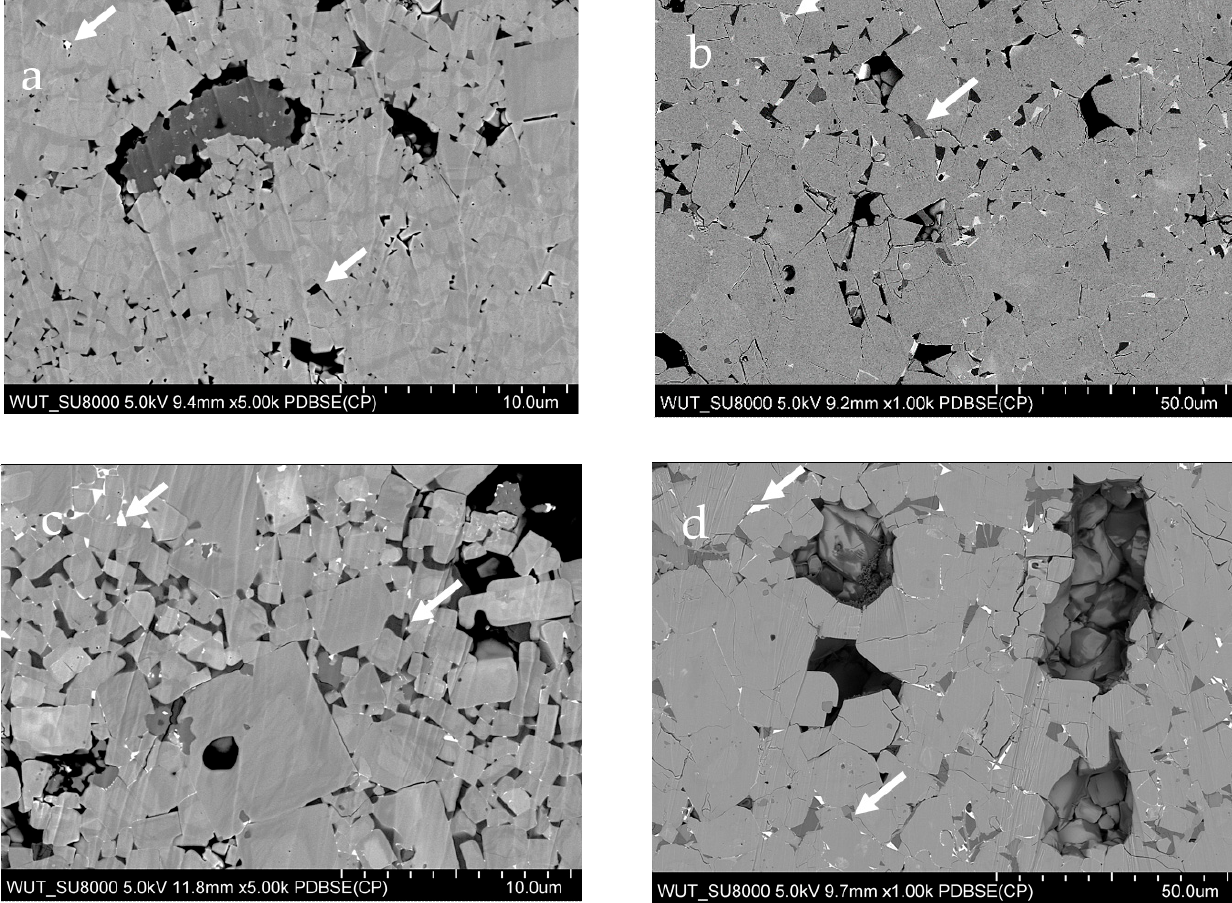
Figure 3. SEM images of the LATP–0.02LSO sintered at 800 °C for 2 h ( a ) and 1000 °C for 12 h ( b ), and LATP–0.1LSO sintered at 800 °C for 2 h ( c ) and 1000 °C for 12 h ( d ). Brighter/darker regions marked with white arrows concern secondary phases (SiO 2 and LiTiPO 5 ).